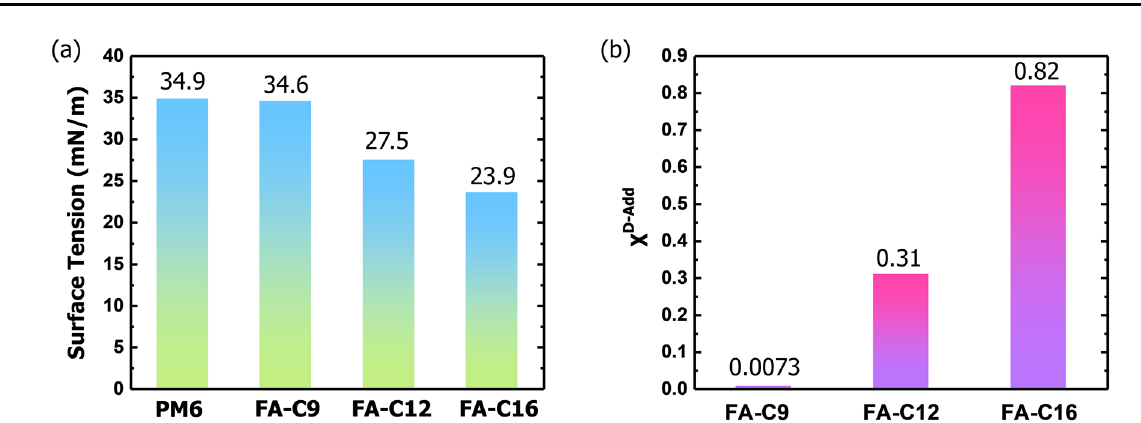
Fig. 4 a Surface tension of PM6, FA-C9, FA-C12 and FA-C16. b χ D−Add between PM6 and